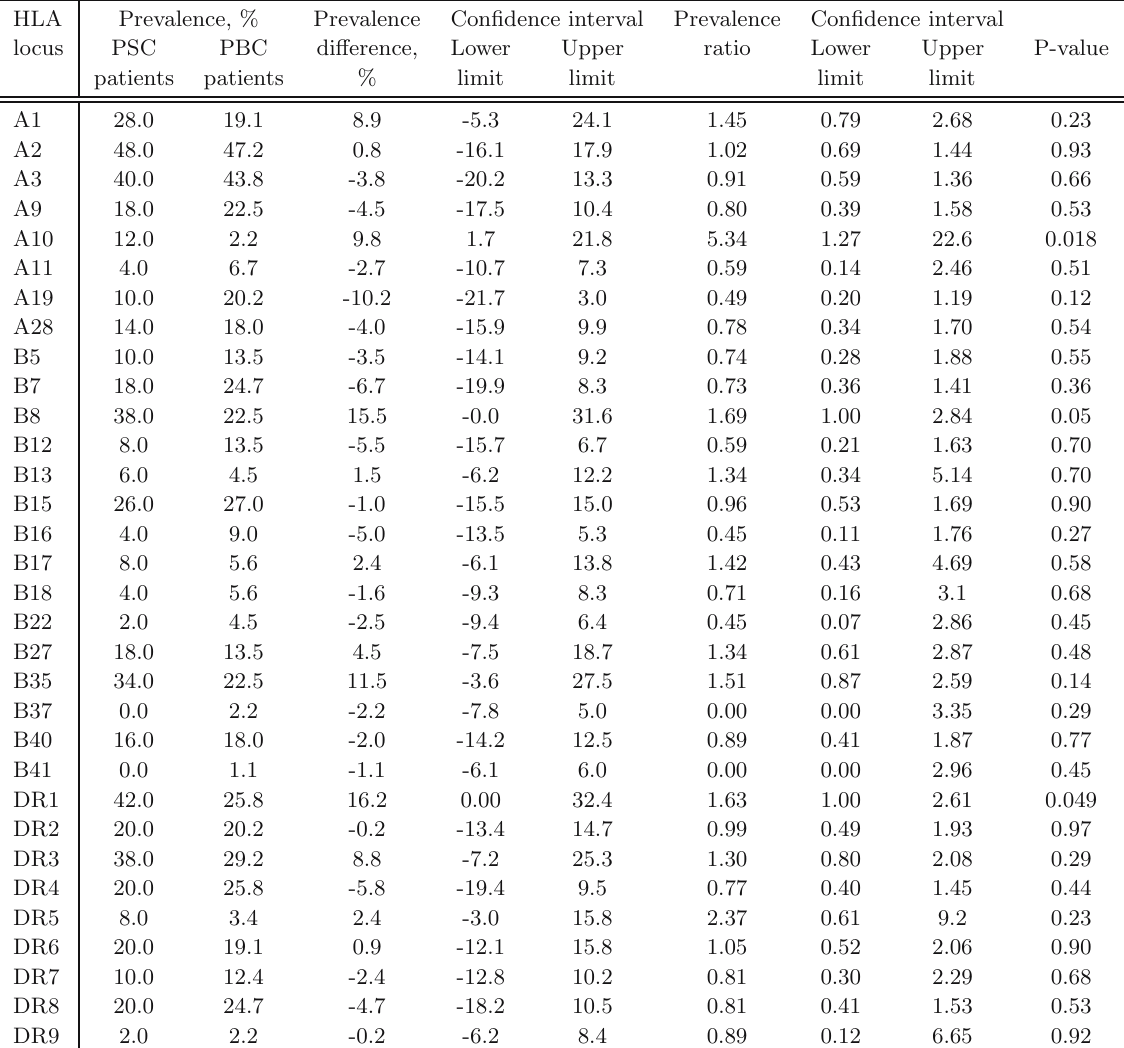
Table 1C Comparison of observed HLA-A,HLA-B and HLA-DR prevalences in Finnish liver transplantation patients due primary sclerosing chloangitis (PSC) and primary bil- iary cirrhosis (PBC) in terms of the prevalence difference and prevalence ratio as well the associated large-sample significance probabilities (2-sided P-values) and 95% confidence intervals (lower and upper limits). Comparisons involving zero prevalences in both series are deleted. Confidence interval Prevalence Confidence